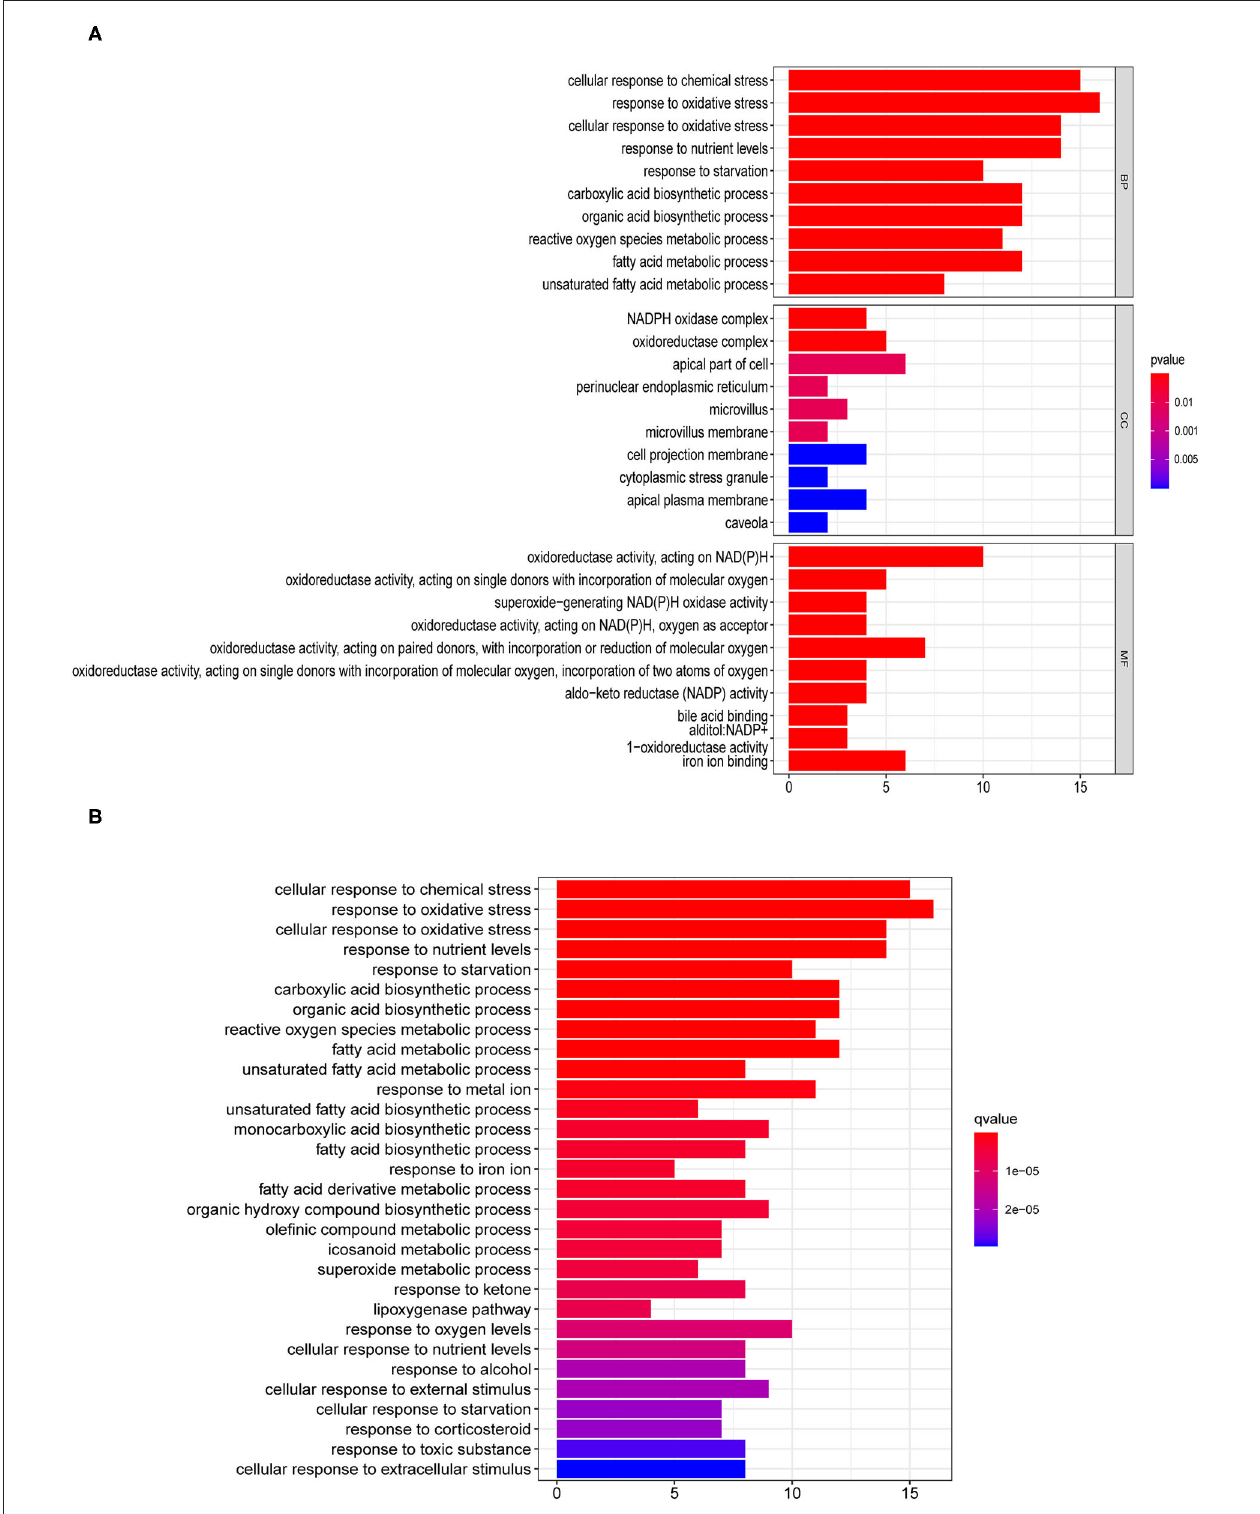
FIGURE 1 | Enrichment pathway analyses for differentially expressed genes (DEG) related to ferroptosis. (A) Gene ontology (GO) and (B) Kyoto Encyclopedia of Genes and Genomes (KEGG) analyses of differentially expressed ferroptosis-related genes.